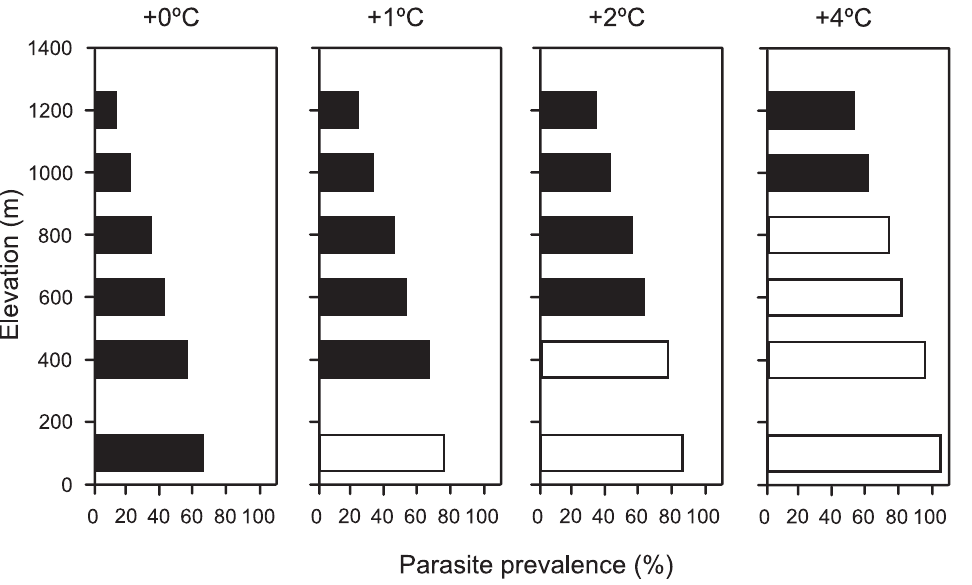
Figure 4. Elevational shifts upwards of bird distributions. One of the mechanisms proposed to compensate increments of parasite prevalence at 0, 1, 2 and 4 u C increase in temperature. Filled bars represent the predicted distribution of birds with increments of temperature. At 0 u C all bars are filled representing the actual distribution of birds along the elevation gradient, with prevalence variation from 64% in the lowlands to 16% at the highest elevations. For each 1 u C increase in temperature, bird distributions need to ascend 200 m in elevation in order to avoid an increase in parasite prevalence. Open bars indicate that birds at that site shifted upwards to the next elevation site to avoid an increase in parasite prevalence, leaving that site unoccupied. Failure to make such a distribution shift would potentially result in higher mortality or reduced reproduction because of elevated blood parasite loads. The shifts in parasite loads are likely to be very large. At an altitude of 1200 m, for example, a 4 u C temperature rise is predicted to increase parasite prevalence from 16% to 50%. At this higher temperature, only birds that currently live at 400 m or below will be able to offset increases in parasite prevalence by shifting their distributions upwards; for birds currently living above 400 m, some increase in parasite prevalence are